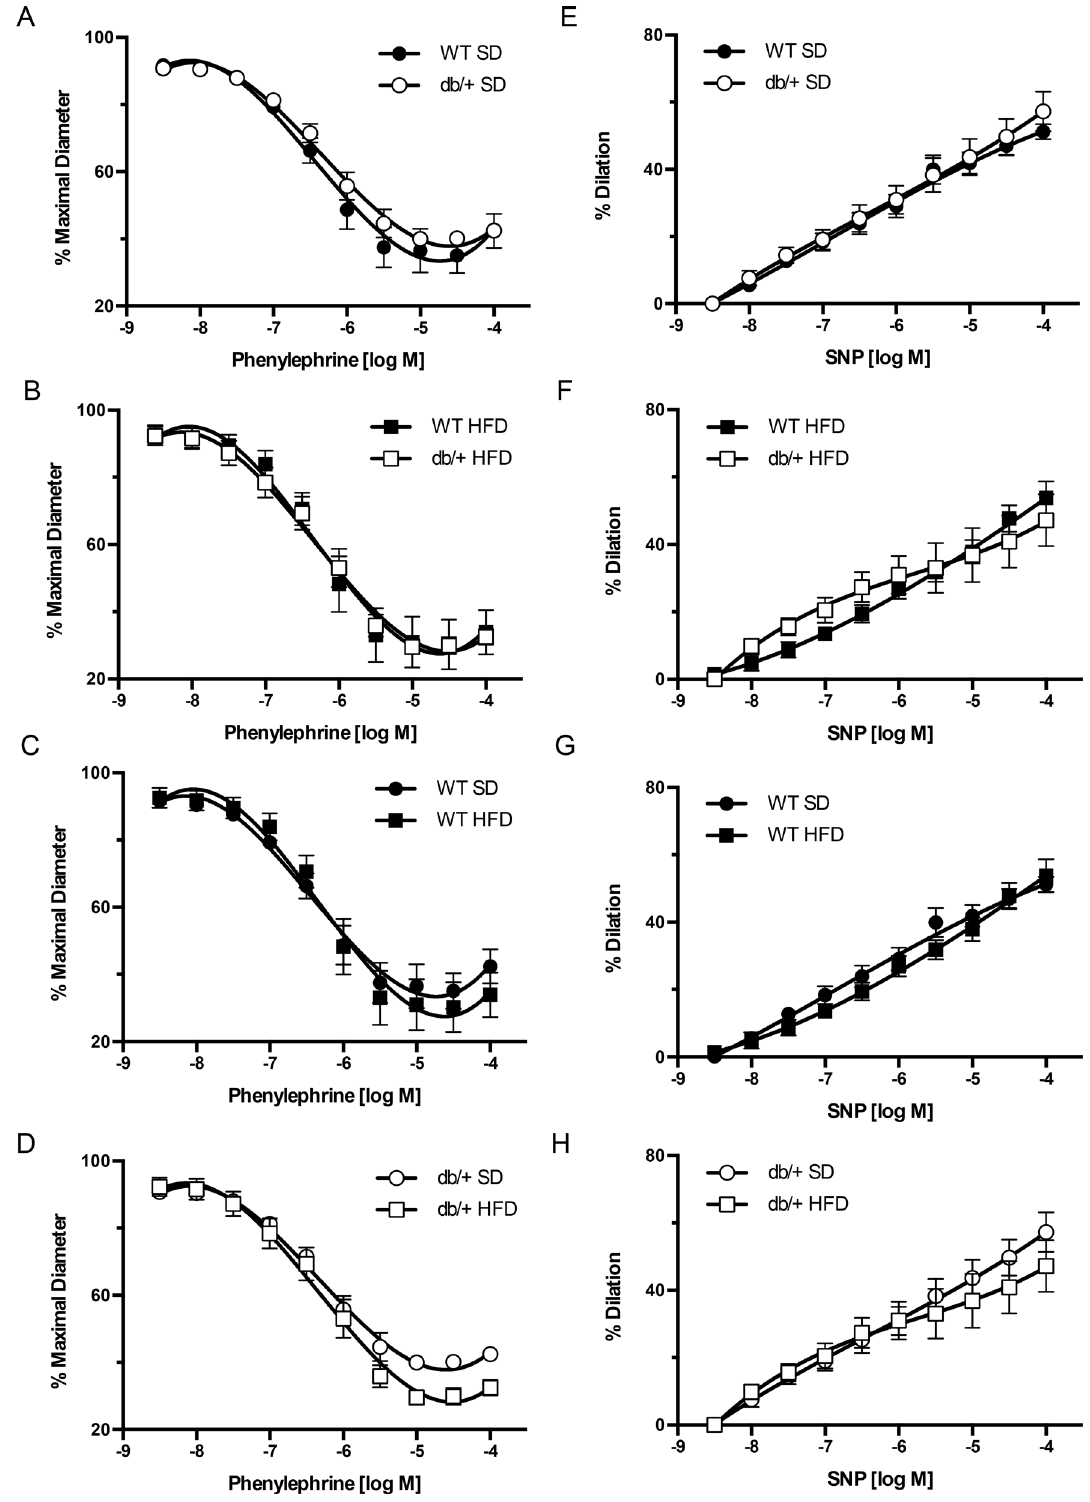
Fig 4. Effect of maternal environment and offspring diet on mesenteric resistance artery responses to phenylephrine and sodium nitroprusside (SNP). All blood vessels were obtained from adult (31 week-old) wild type (WT) male offspring of WT-control or Lepr db/+ (db/+) dams. (A-D) Phenylephrine-induced vasoconstriction responses. (E-H) SNP-